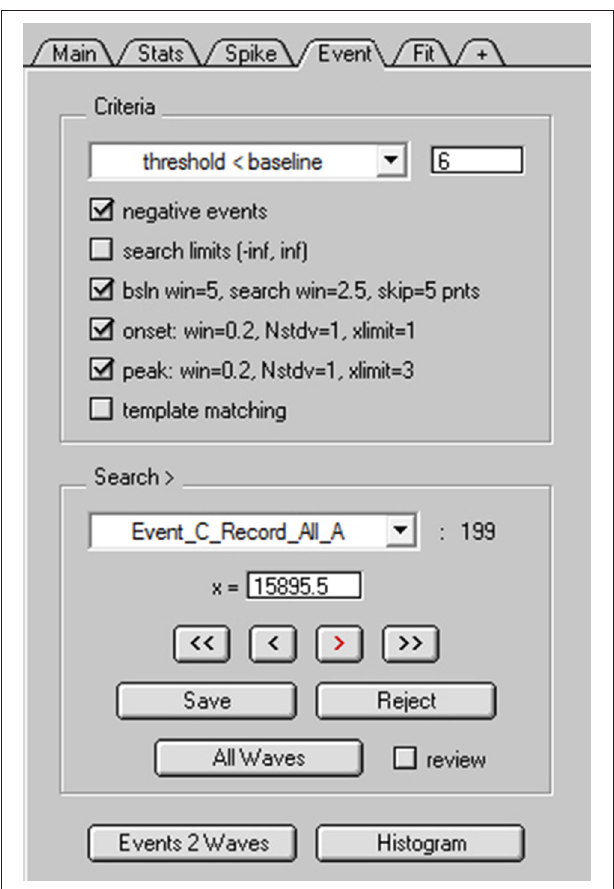
FIGURE 8 | NeuroMatic’s spontaneous event detection. Screen capture of the criteria and search controls for the Event tab during spontaneous EPSC detection. Criteria controls (Top) define which search algorithm to use (threshold-level crossing or template matching) and to define key search parameters. Search/Review controls (Bottom) are used for advancing forward/backward through the events, saving/rejecting detected events to/from the event table, setting the current search time (x = ), activating auto event detection (All Waves) and managing the event table (here, the current table is “Event_C_Record_All_A”). Clicking the “review” checkbox turns off the search algorithm and allows users to inspect “successful” or “rejected” events, with the ability to move events between the two categories via the Save/Reject buttons. Once the user is satisfied with the event detection results, events can be copied to new waves via the “Events 2 Waves” button and the new waves can be selected for analysis (see Figure 9 ). “baseline” is a sliding average computed within a small window (blue line). Note, the sliding baseline window is an improvement to the sliding baseline point, A ( i ), used by Kudoh and Taguchi (2002) since the window, typically 2–10 ms, is less sensitive